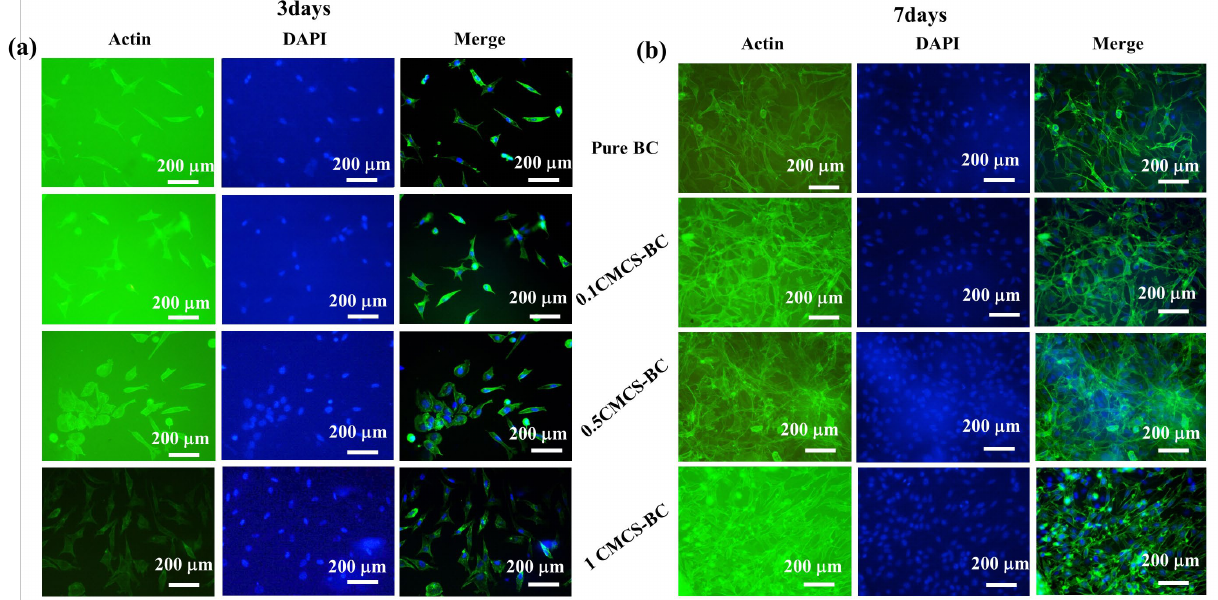
Figure 7. Fluorescence images of stained fibroblasts cells on pure BC and CMCS–BC hydrogels for ( a ) 3 and ( b ) 7 days under 10× magnification (scale bar 200 μm). Cell nuclei were stained with DAPI (blue), and the actin cytoskeleton was stained with Alexa flour-conjugated phalloidin (green).